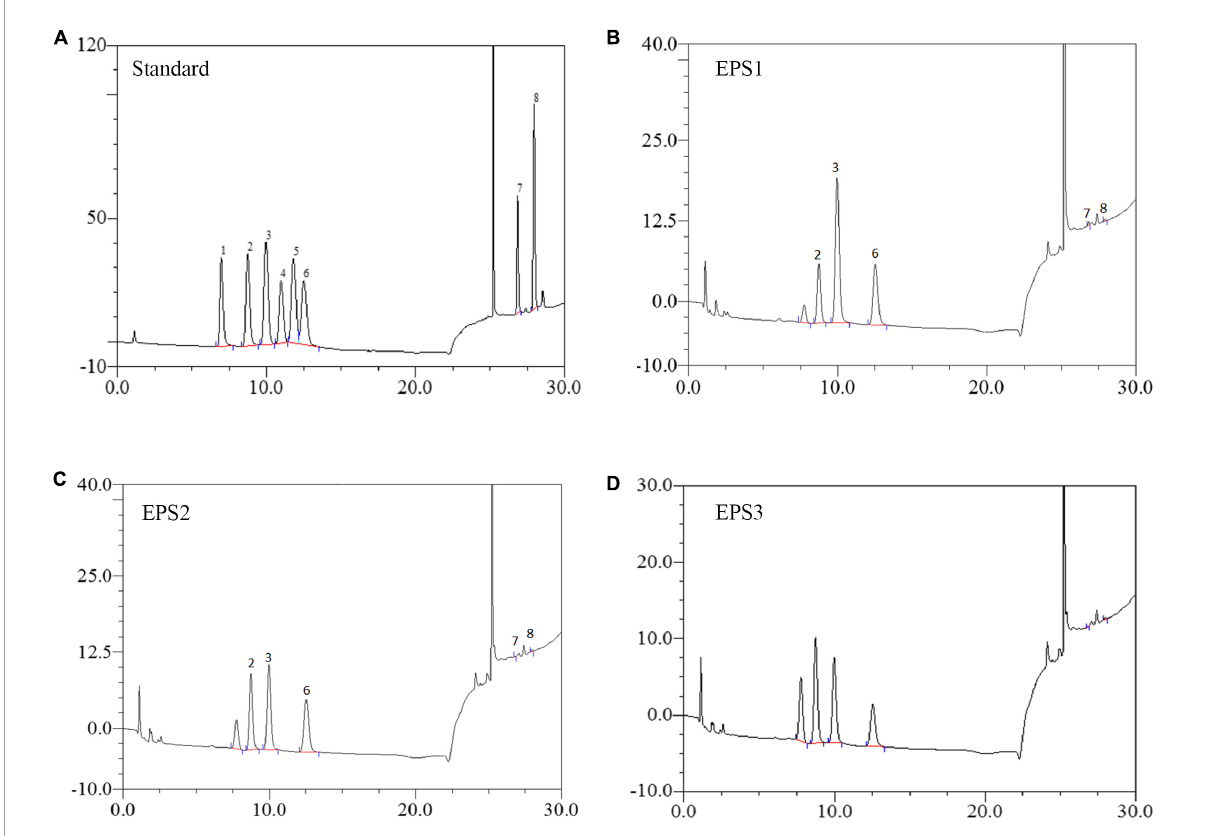
FIGURE4 HPLC chromatogram of the monosaccharide components of EPSs from L. pantheris TCP102. (A) Monosaccharide standard, the peak values of 1–8 represent arabinose, galactose, glucose, xylose, mannose, ribose, galacturonic acid, and glucuronic acid, respectively. (B) EPS1, (C) EP2, and (D)